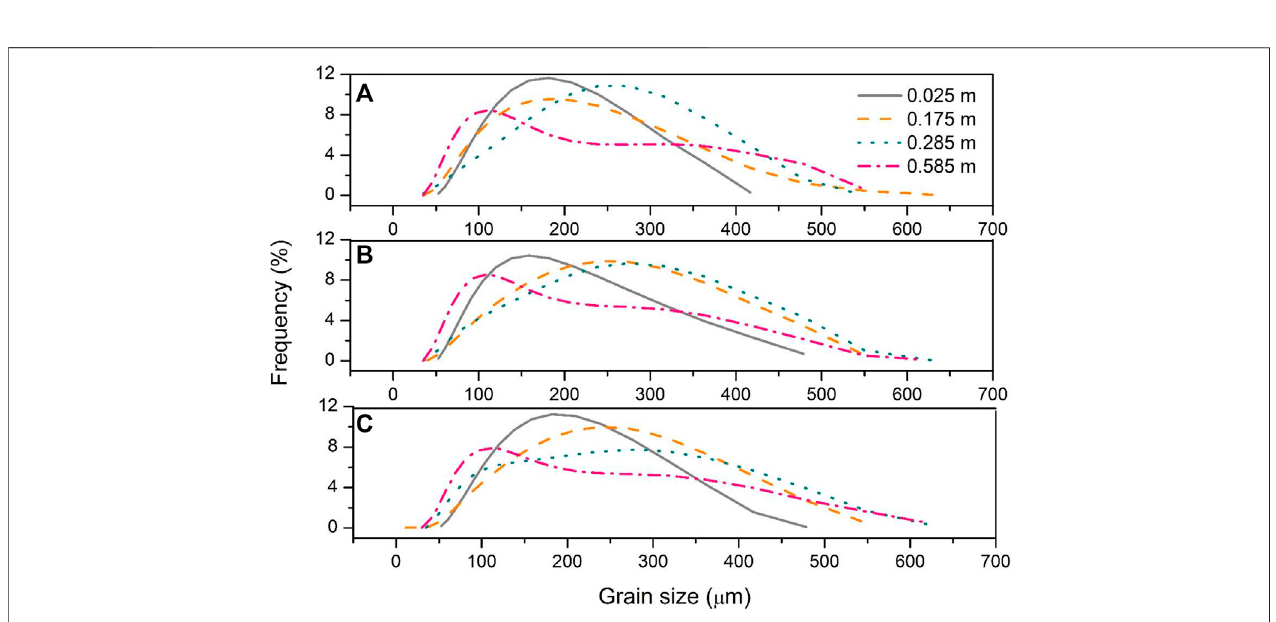
FIGURE 4 | The grain-size frequency of wind-blown sand samples changing with height in the three transport events. (A) 20180502 event, (B) 20180504 event, and (C) 20180507 event.